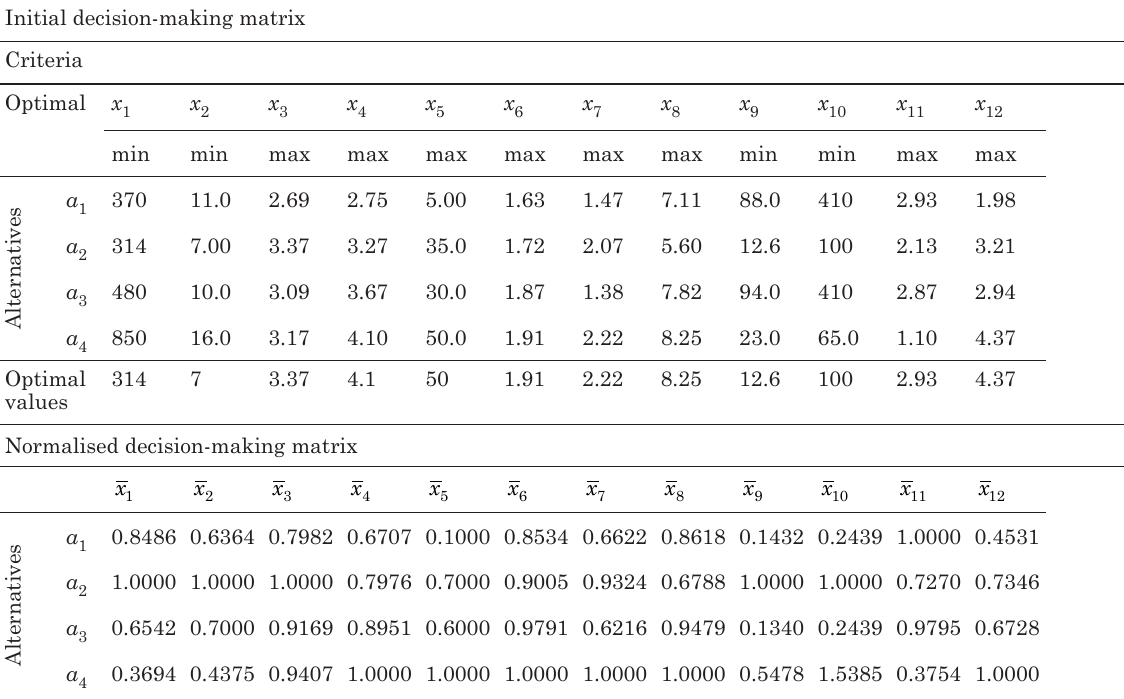
table 5. ranking of alternatives by applying the multiplicative exponential generalized optimality criterion of a